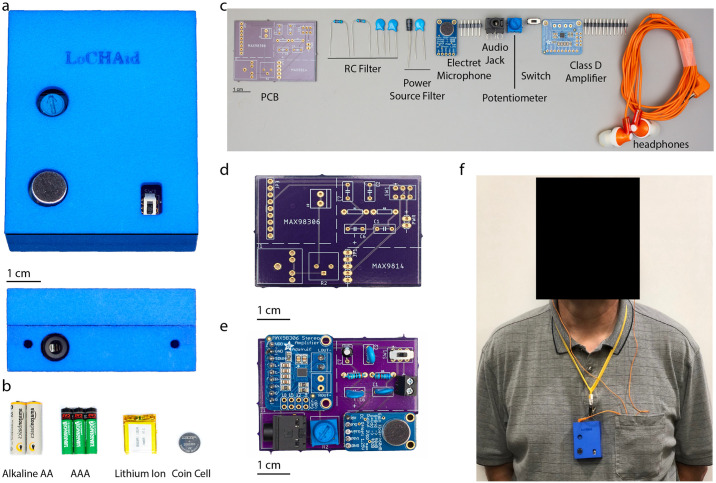
Construction and components of the LoCHAid.a. The LoCHAid is shown in its top view, with its 3D printed polyamide (Nylon 12) case tilted. The side view of the audio jack opening and holes for attaching material for neck wear are shown below. The LoCHAid in its case has a size of 6.70 mm by 5.70 mm. The audio jack can incorporate any standard 8 mm sound transducer. b. Displays various types of batteries such as AA, rechargeable AAA, Lithium Ion flat pack, as well as lithium ion coin cell that can be used to power the device. The device has a power requirement that is between 3-5.5 V. The amount of batteries denote the the number required to power the device. c. The required parts to assemble the device are shown here with group labels; specific details are given in Table 1. d. View of the custom printed circuit board (PCB) without any components. e. View of the PCB with components soldered on. f. View of the body-worn device by an anonymous 65 year old male as part of the intended audience of the device.